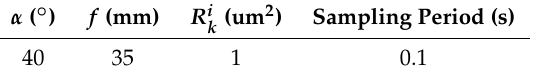
Table 2. Parameters of landmark sensor.